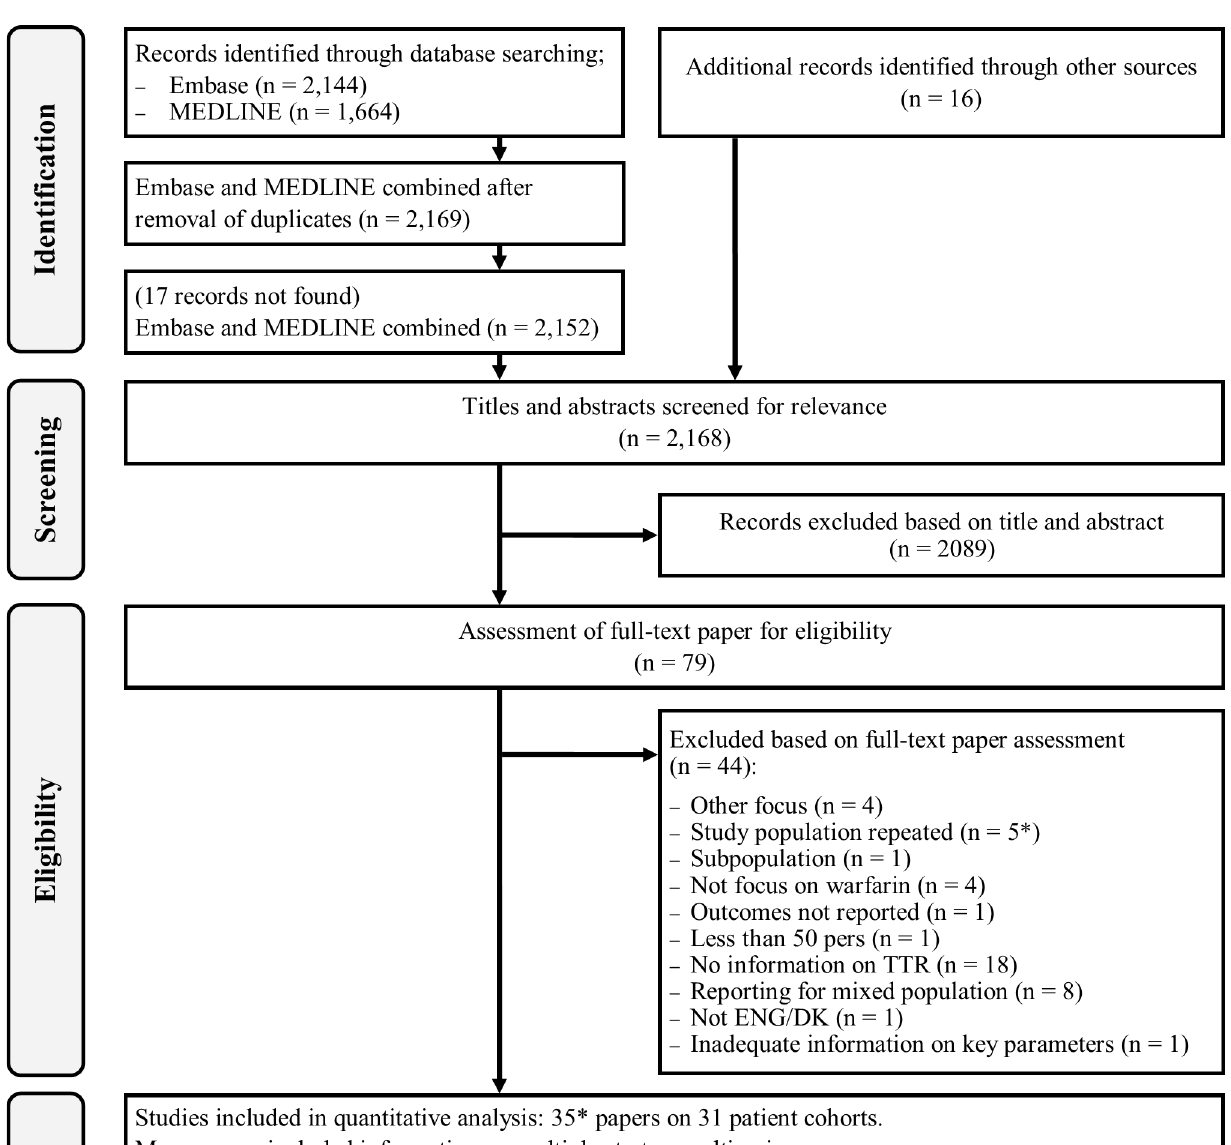
Fig 1. Flowchart of literature search and study exclusions. Adapted from Liberatiet al. 2009[10]. Numbers in parenthesis in the lowermost box indicatethe number of studies includedin random-effects multivariable meta-regressions. Four papers[16,18,19,21]on the same patient cohort were retainedas they held informationon outcomesof interest not reportedin the otherwiseincludedpaperson that patient cohort [6,15,17,22]. https://doi.org/10.1371/journal.pone.0188482.g001 Publication bias was indicated for the 3rd (highest) tertiles of mean TTR for SSE ( p = 0.07), HS ( p = 0.10), and IS ( p = 0.01) by Egger’s regression statistics, though the basis for analysis was small for HS and IS (number of studies < 10). Slight asymmetry was observed for the